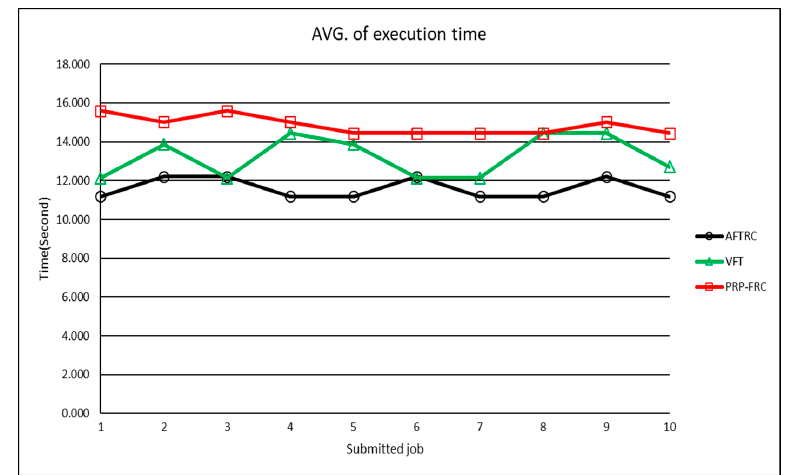
Figure 9. Average of execution time of the architectures.